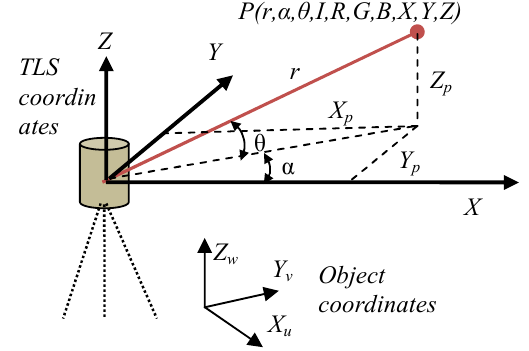
Figure 1. Laser scanner measurements and coordinates.